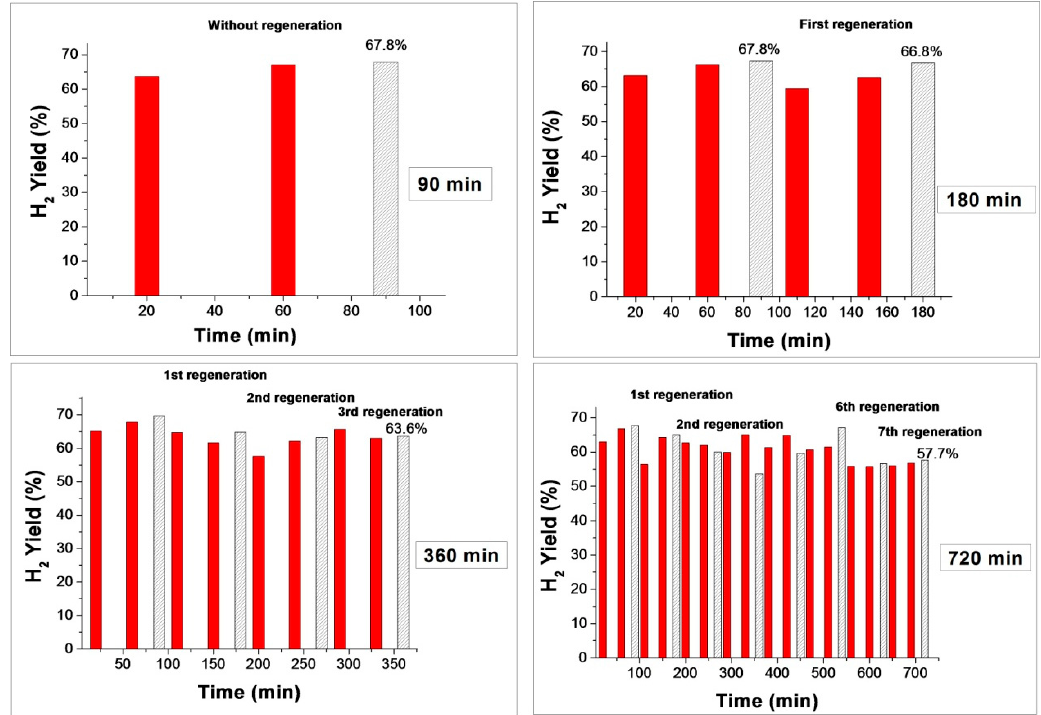
Figure 7. Comparison of different H 2 yields (%) obtained from 90, 180, 360, and 720 min of reaction (the white bar is a limit between each regeneration cycle).